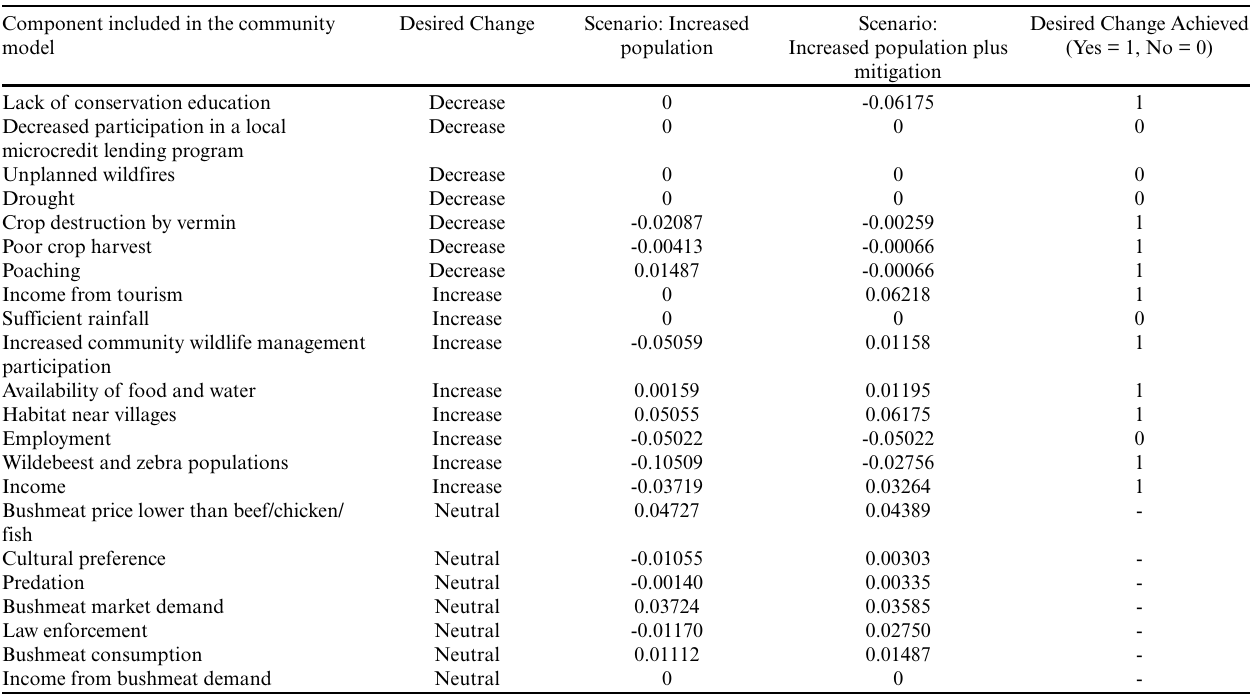
Table 2 . Comparison of scenario analyses and preferred state of the social-ecological system. Component included in the community